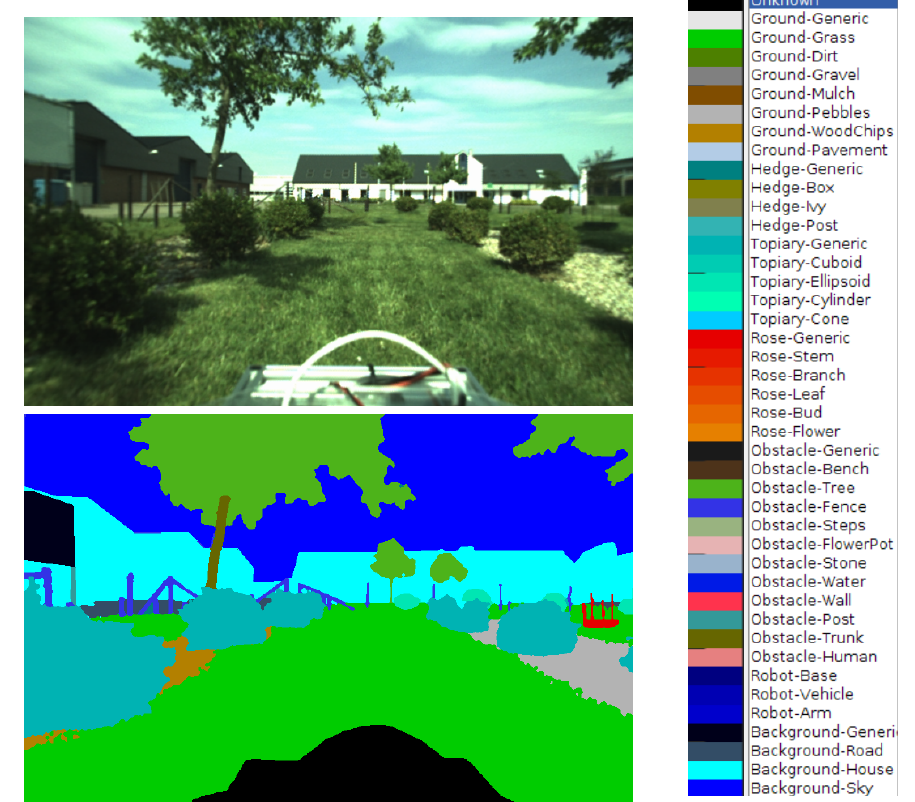
Figure 4. Sample annotated image. The captured image (top left) and its semantic map (bottom left) with colour-coded semantic classes (right). The black region at the bottom masks the capture system. The labels X-Y at the right form a hierarchy, where X is the top base class and Y the subclass.